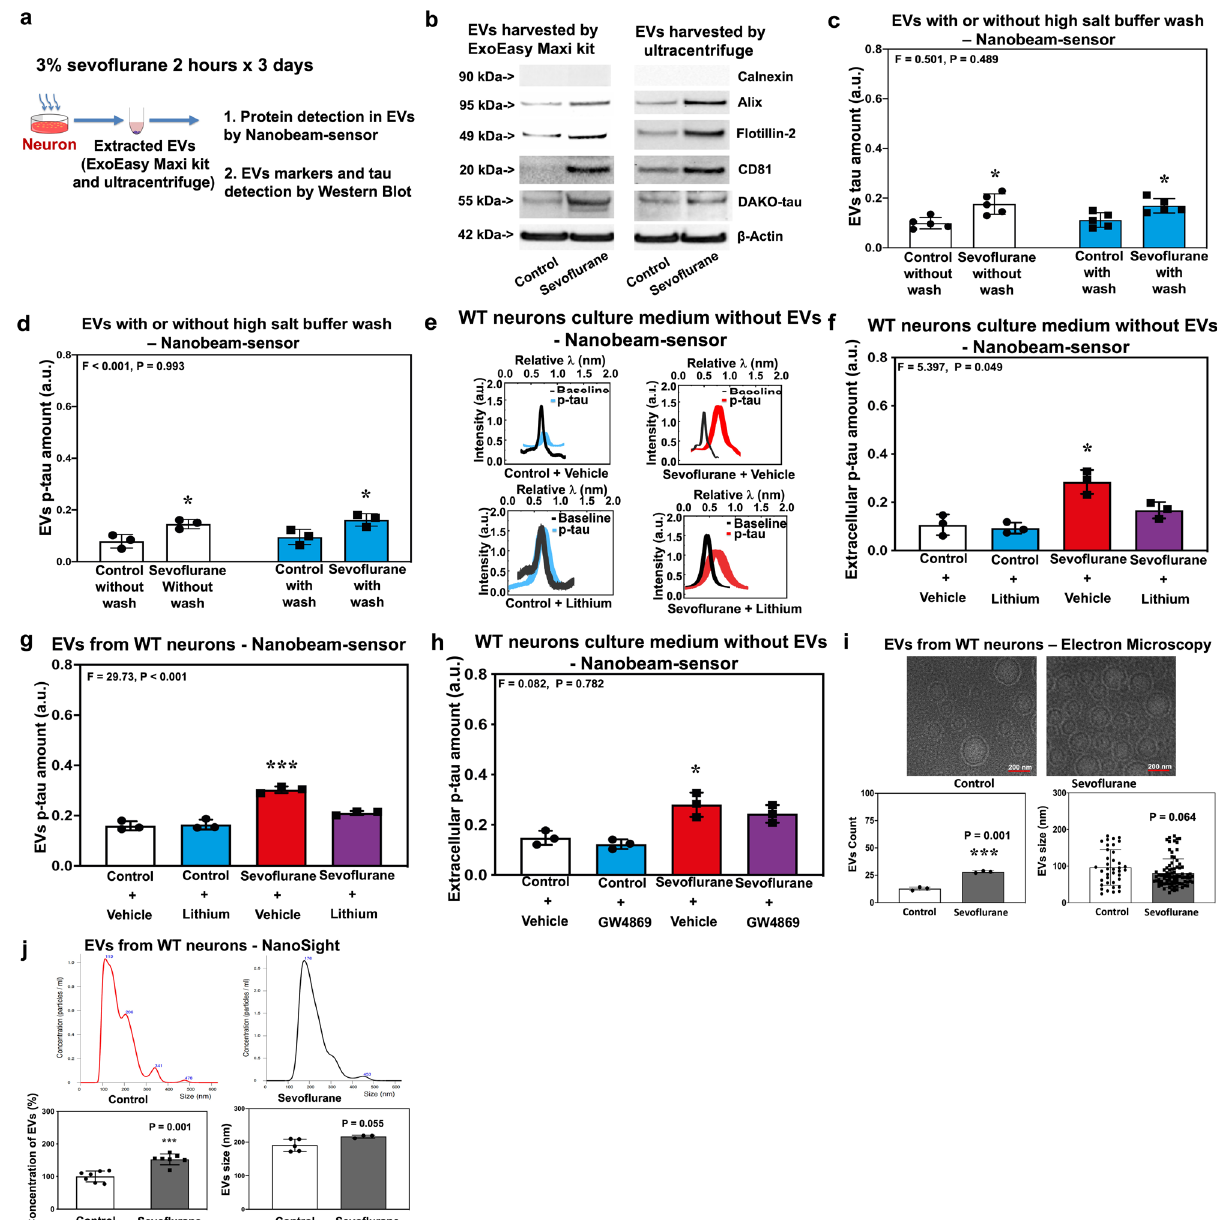
Fig. 3 Sevo fl urane caused the presence of tau and p-tau in EVs. a Experimental design. b Effects of sevo fl urane on the markers of EVs and tau in EVs. c Amounts of tau in EVs with or without treatment of high-salt buffer wash. d Amount of p-tau in EVs with or without treatment of high-salt buffer wash. e Nanobeam-sensor spectrum data showing extracellular p-tau in WT neuron culture medium without EVs. f Quanti fi cation of nanobeam- sensor measurement of p-tau in e . g Nanobeam-sensor measurement of p-tau in the EVs extracted from neurons with and without lithium treatment. h Nanobeam-sensor measurement of extracellular p-tau amounts in neuron culture medium after extraction of EVs with and without GW4869 treatment. i Electron microscope measurement of the count and size of EVs. j NanoSight analysis of the concentration and size of EVs. Two-way ANOVA and post-hoc analysis with Bonferroni were used to analyze the data presented in Figs. 3c, d, f, g, h. Student ’ s t test was used to analyze the data presented in Fig. 3i, j. The P values of the two-way ANOVA refer to the interaction of group (control condition versus sevo fl urane), method (with versus without high-salt buffer wash), or treatment (vehicle versus lithium or GW4869). The P values of post-hoc analysis with Bonferroni refer to the differences in the tau or p-tau amounts between control condition and sevo fl urane. P -values of the Student ’ s t test (Fig. 3i, j) refer to the difference of count, concentration, and size between control condition and sevo fl urane. * P < 0.05, and *** P < 0.001. N = 3 biologically independent samples in each group in Fig. 3d, f, g, h, i (left panel) and Fig. 3j (right panel); N = 5 biologically independent samples in each group in Fig. 3c, j (right panel); N = 7 biologically independent samples in each group of Fig. 3j (left panel); N = 38 EVs in the control group and N = 84 EVs in the sevo fl urane group of Fig. 3i (right panel). Error bar indicates standard deviation. P-tau phosphorylated tau, EVs extracellular vesicles, WT wild-type, EM electron